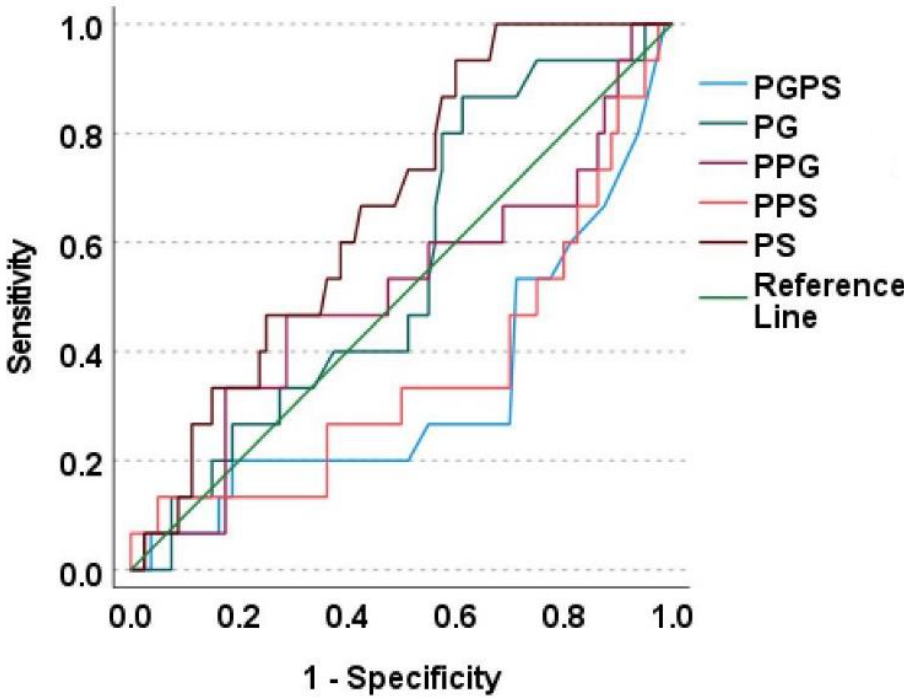
Figure 2. ROC plot for paracetamol metabolites with CYP1A2*1K. This is a ROC plot where the diagonal green line indicates the reference line. The brown line above the reference line represents the predictive ability of paracetamol sulphate. All other metabolites were observed with their lines falling below the reference line thereby they do not significantly predict the